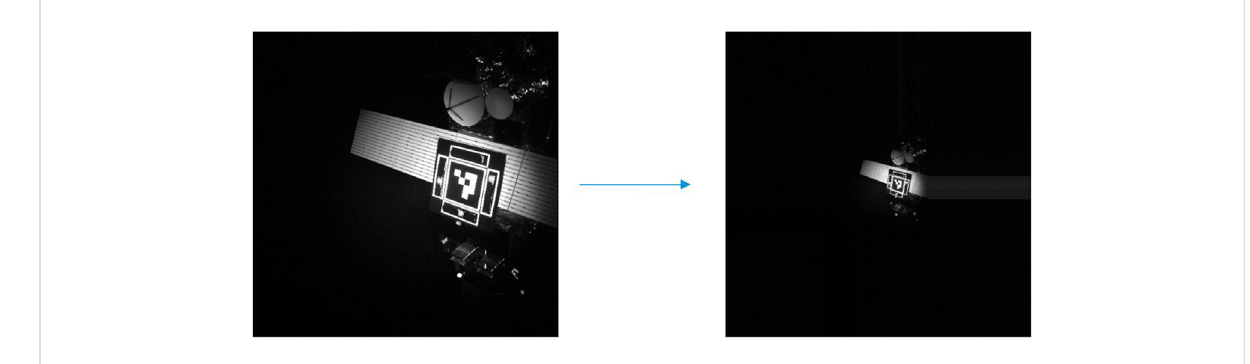
FIGURE 10 Image scaling to enable Blender model